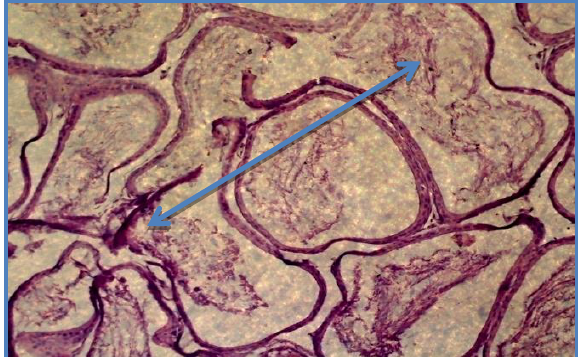
Figure, 8: Cross section of rat epididymis of group T2 showing the lumen was overfilled with sperms (H and E stain 10x).